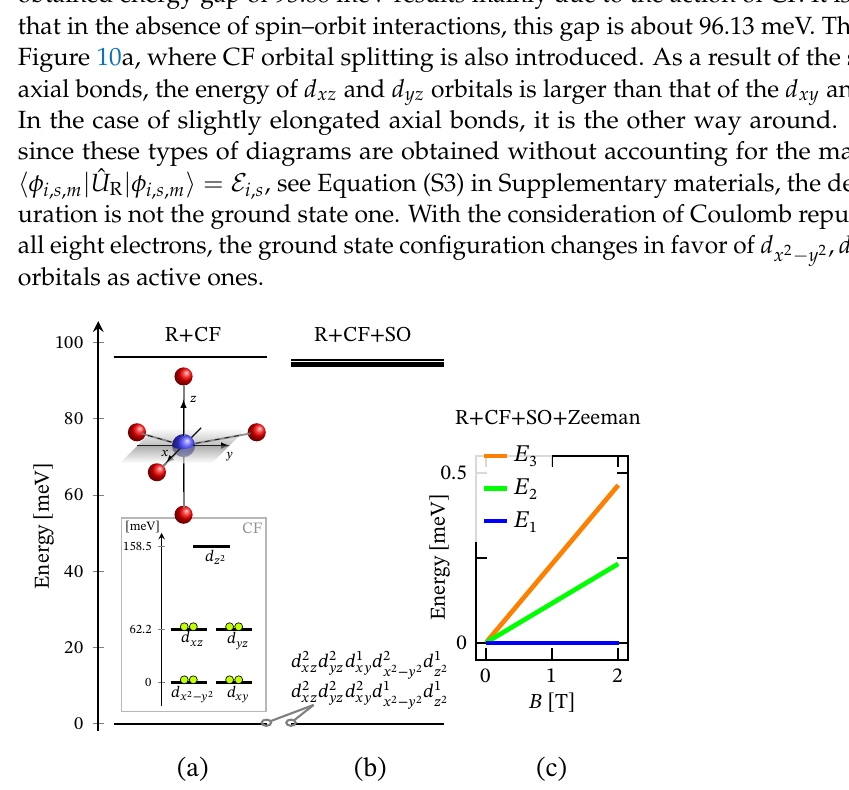
Figure 10. Low-lying energy level sequence for the trigonal bipyramidal coordination. The model pa- rameters are given at the end of Section 2.1. ( a ) Shows CF splitting all repulsive Coulomb interactions accounted for. The orbital energy diagram and the corresponding electrons’ (circles) configuration resulting from CF is shown in the inset. ( b ) Depicts the spectrum with the contribution of spin–orbit interactions. ( c ) Shows the Zeeman splitting resulting from the action of the externally applied magnetic